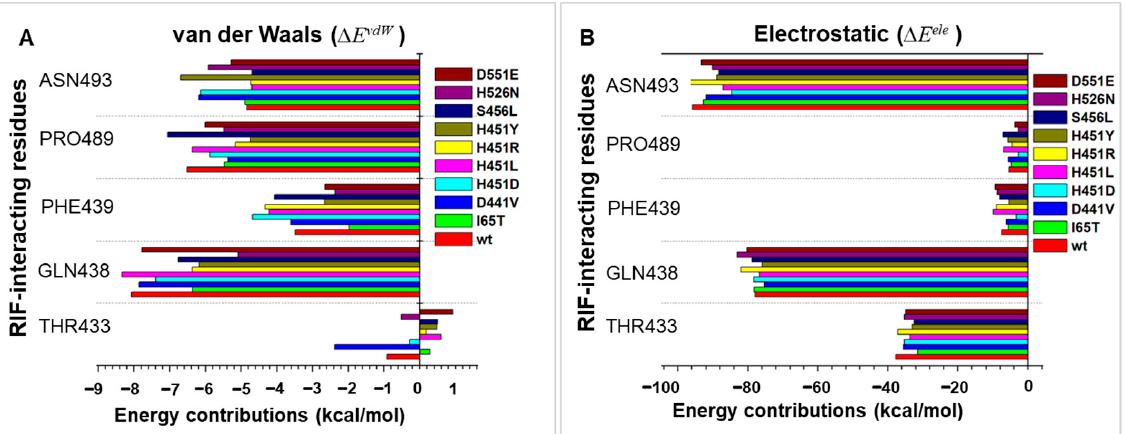
Figure 5 . Mutant-induced RIF destabilization. ( A ) 3D illustration of RIF’s shift from the active pose when in the presence of the studied RIF R mutations. RIF snapshots (stick representation) were tak- en at 0 ns (grey), 250 ns (purple), 500 ns (orange) and 700 ns (brown), respectively. ( B ) The violin plots convey RIF’s stability (with reference to the RIF-BP) for the wt and mt s over the equilibrated timeframes. The dotted lines on the violins represent the 25th, 50th and 75th quartiles, while mean RMSD values are indicated above the plots.